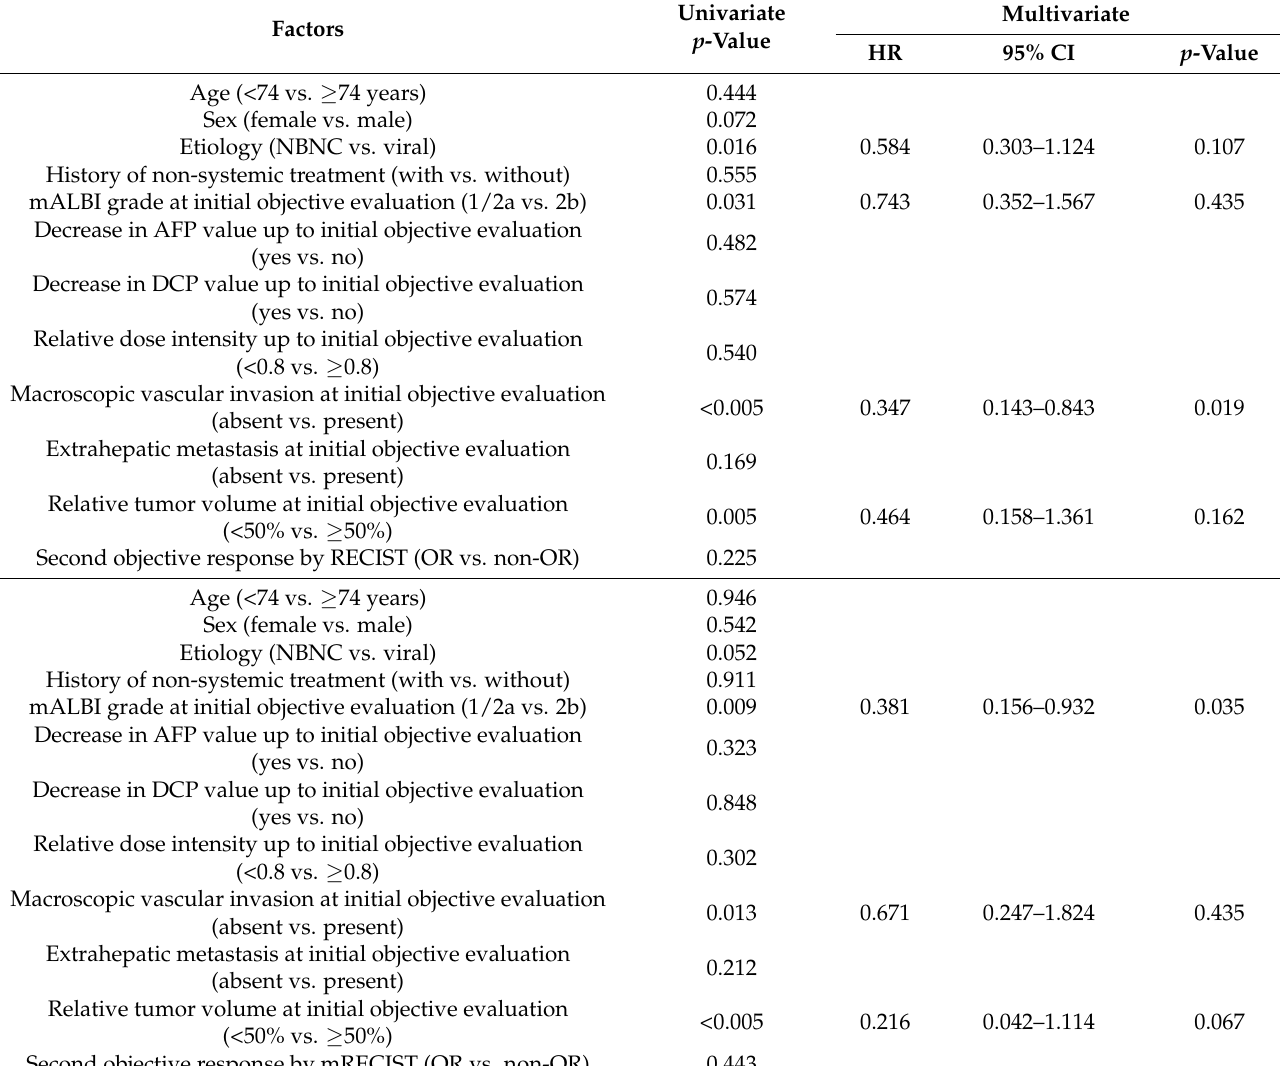
Table 4. Univariate and multivariate analyses of prognostic factors for overall survival from initial objective evaluation in patients with SD at the initial radiological response